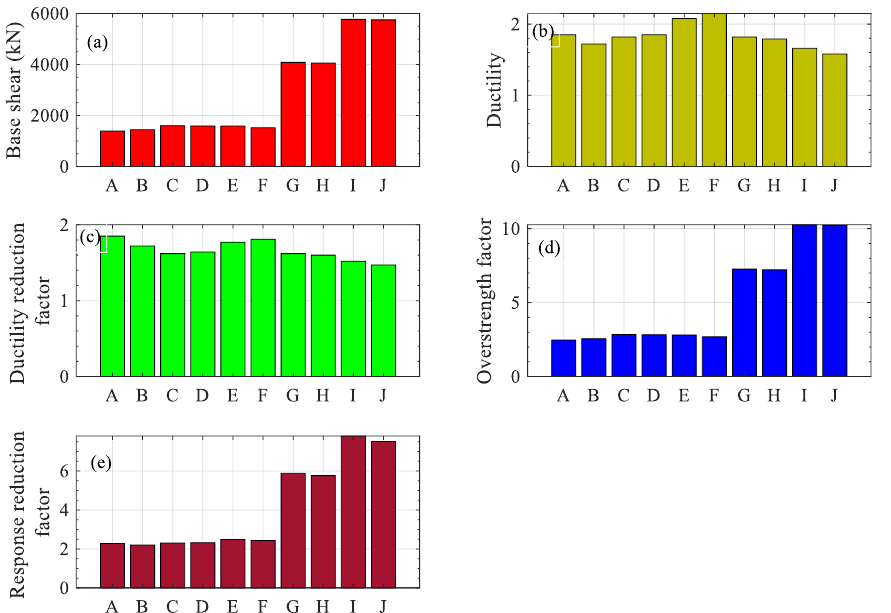
Figure 9. Comparisons of performance parameters for various analysis scenarios: ( a ) Base shear; ( b ) ductility; ( c ) ductility reduction factor; ( d ) overstrength factor; and ( e ) response reduction factor. In this figure, the analysis scenarios represented by alphabets are: A = bare frame with intel beam (X); B = bare frame with lintel beam (Y); C = open ground story, RC-SIM infill with lintel beam (X); D = open ground story, RC-SIM infill with lintel beam (Y); E = open ground story, RC-URM infill with lintel beam (X); F = open ground story, RC-URM infill with lintel beam (Y); G = Full RC-URM infill frame with lintel beam (X); H = Full RC-URM infill with lintel beam (Y); I = Full RC-SIM infill frame with lintel beam (X); J = Full RC-SIM infill frame with lintel beam (Y).